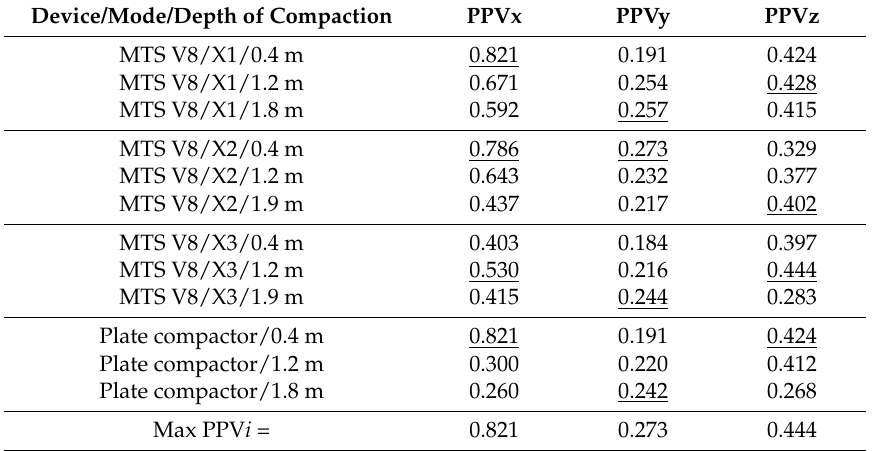
Table 6. Peak component particle velocities at the foundation wall of the building—stage II, mm/s.